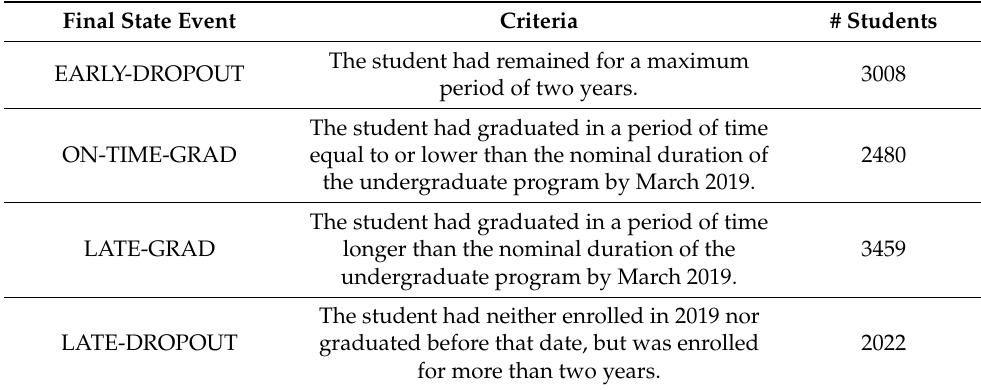
Table 1. Criteria used to define the final state of a student.